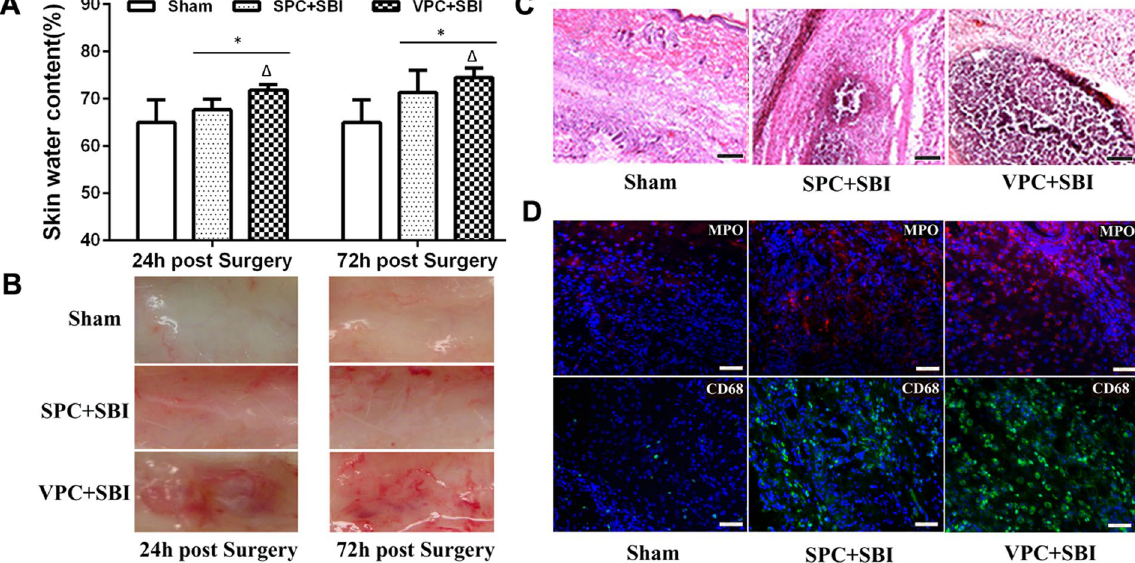
Figure 2. Venom preconditioning (VPC) induced local skin changes at the subcutaneous injection site. (A) Skin water content was increased in VPC + SBI group compared to Sham and SPC + SBI groups 24 h and 72 h after SBI. * p < 0.05 vs Sham, ∆ p < 0.05 vs SPC + SBI. Data are shown as mean ± SD. n = 8/group. (B) VPC induced local inflammation at the skin injection site. Subcutaneous region showed apparent redness, edema and congestion in VPC + SBI group compared to Sham and SPC + SBI groups. n = 3/group. (C) Hematoxylin and eosin (H&E) staining of skin samples showing neutrophil infiltration in VPC + SBI group compared to Sham and SPC + SBI groups 24 h after SBI. n = 3/group. Scale bar = 100 μ m. (D) Immunofluorescence staining of skin samples showing expression of neutrophil marker myeloperoxidase (MPO) (Texas Red-red) and macrophage/ microglia marker (CD68) (FITC-green) with DAPI (blue) in VPC + SBI group compared to Sham and SPC + SBI groups 24 h after SBI. n = 3/group. Scale bar = 50 μ m.